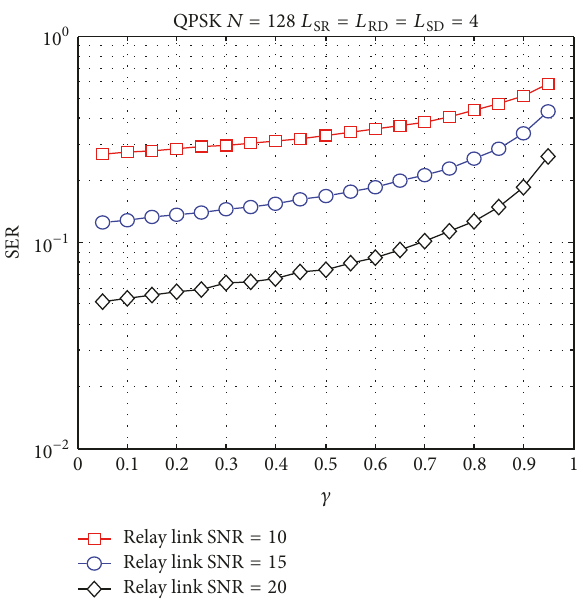
Figure 4: SER performance versus power-allocation factor at the relay.